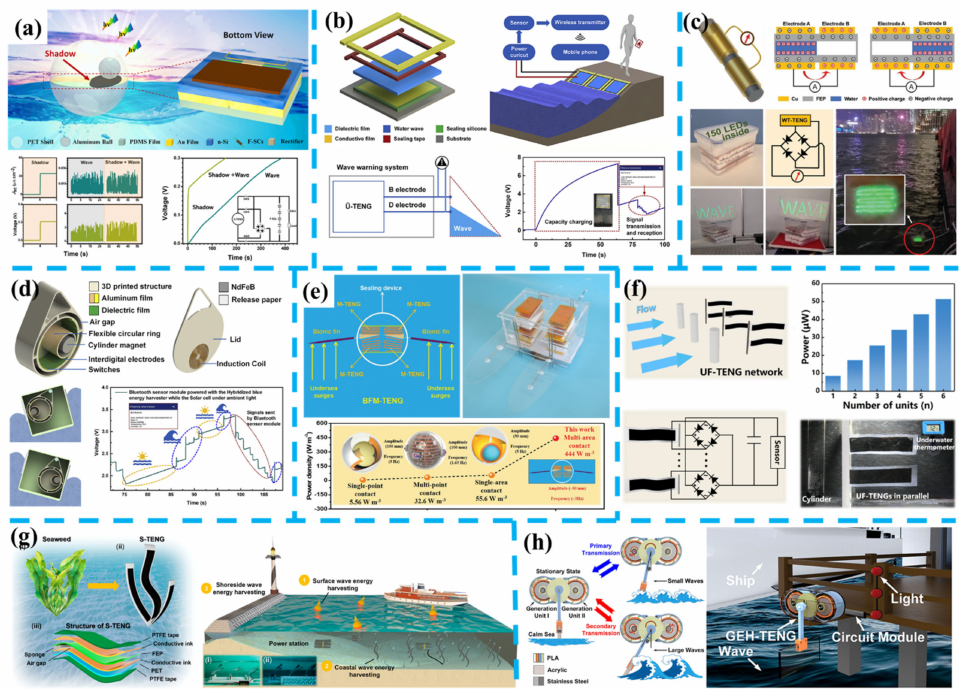
Figure 9. Blue energy. ( a ) Shadow enhanced self-charging power system for wave and solar energy harvesting from the ocean (Reprinted with permission from ref. [284]. Copyright 2021 Nature). ( b ) Thin-film blue energy harvester and seashore IoT applications (Reprinted with permission from ref. [289]. Copyright 2019 Elsevier). ( c ) Multi-mode water-tube-based blue energy harvester (Reprinted with permission from ref. [290]. Copyright 2021 John Wiley & Sons). ( d ) Hybridized blue energy harvester aiming at all-weather IoT applications (Reprinted with permission from ref. [291]. Copyright 2020 Elsevier). ( e ) Bionic-fin-structured TENGs for undersea energy harvesting (Reprinted with permission from ref. [292]. Copyright 2020 John Wiley & Sons). ( f ) An underwater flag-like TENG for harvesting ocean current energy (Reprinted with permission from ref. [293]. Copyright 2019 Elsevier). ( g ) Flexible seaweed-like TENG for marine IoT applications (Reprinted with permission from ref. [294]. Copyright 2021 American Chemical Society). ( h ) Ocean wave graded energy harvesting and condition monitoring with TENG (Reprinted with permission from ref. [295]. Copyright 2021 American Chemical